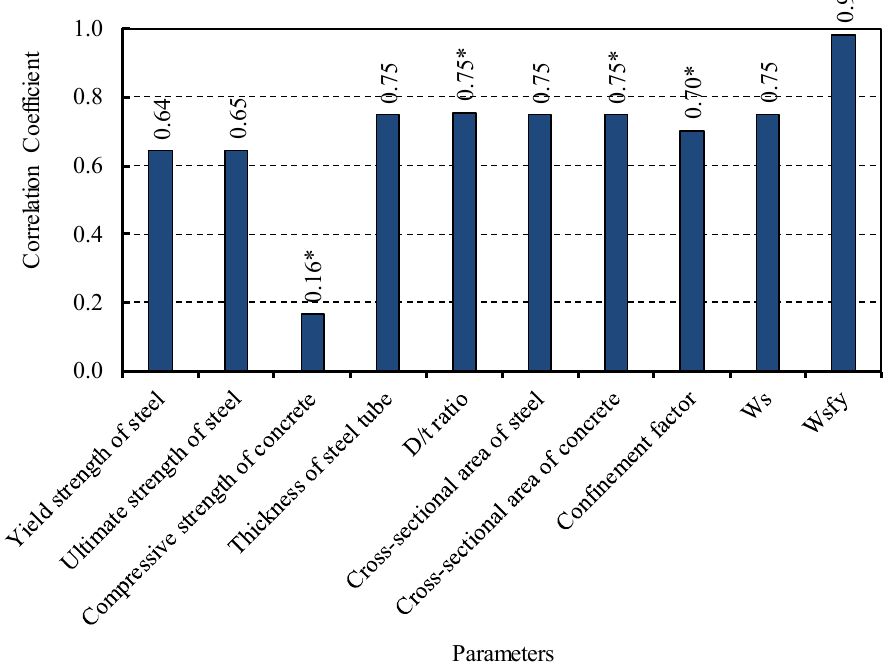
Figure 13. Correlation between M e and parameters.